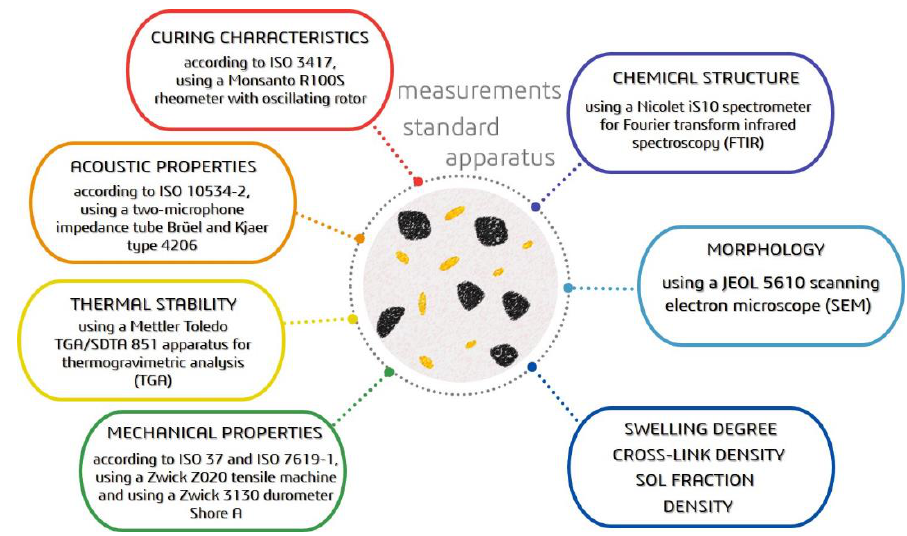
Figure 2. Summary of used methodology.